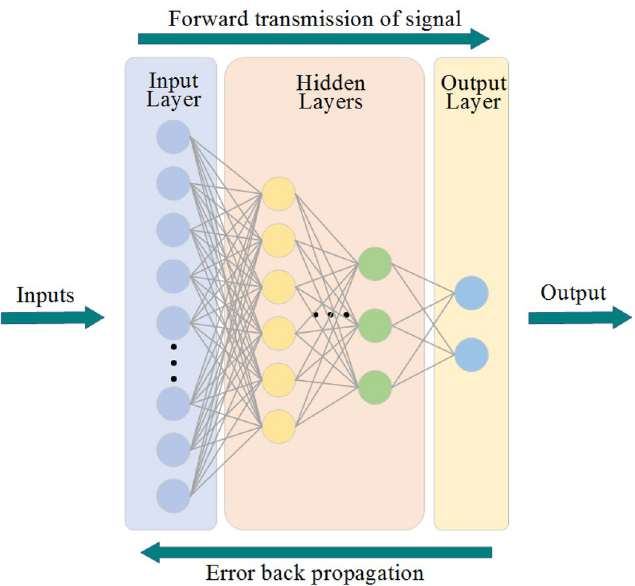
Figure 11. Multilayer perceptron structure.